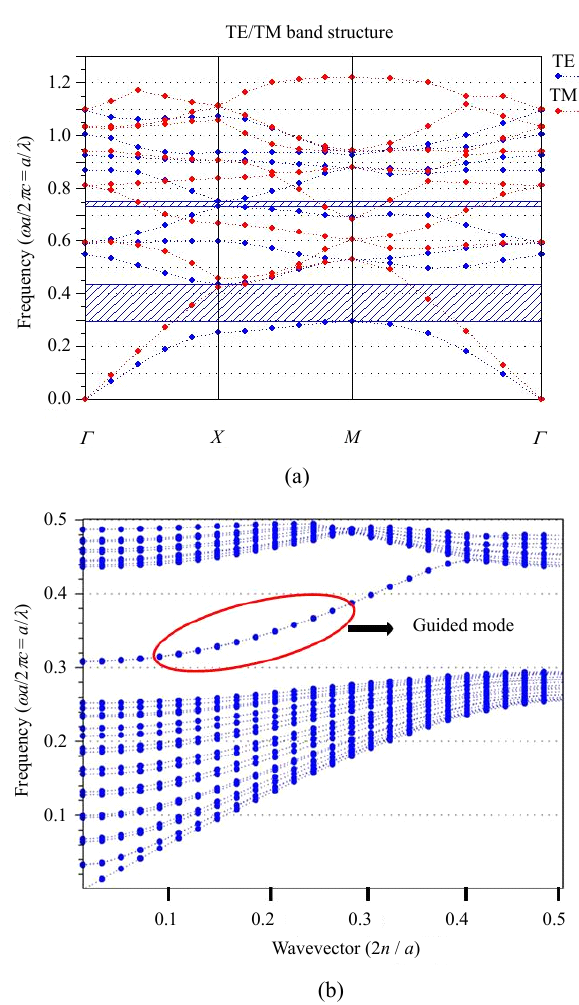
Fig. 2 Band diagram for circular rods in 21 × 17 square lattice: (a) without any defects and (b) with line and point defects.